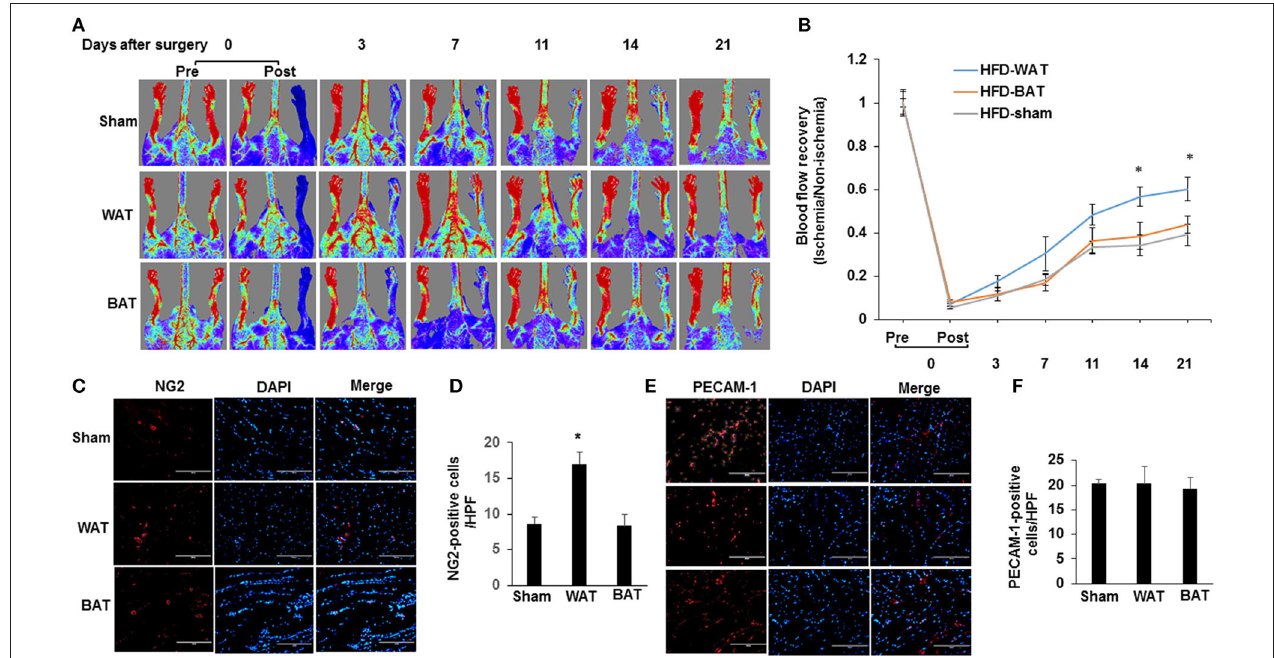
FIGURE 2 | WAT transplantation reverses HFD-impaired blood flow perfusion after femoral artery ligation. (A) Representative laser Doppler images of mouse hindlimbs at indicated time points after femoral artery ligation. Pre and post indicate immediately before and after surgery, respectively. Red color denotes normal perfusion. (B) Mean ratio of blood flow in ischemic and non-ischemic hindlimb foot pads for all animals at indicated the time points ( n = 9 per group; * P < 0.05 vs. BAT-transplanted and sham mice). (C) Representative images of arterioles as assessed by anti-NG2 immunostaining in ischemic adductor muscles 21 days after femoral artery interruption. Distance bars, 100 µ m. (D) The mean arteriole density in ischemic adductor muscles was significantly greater in WAT-transplanted mice ( n = 9 per group; * P < 0.05 vs. BAT-transplanted and sham mice). (E,F) Representative images of capillary as assessed by anti-PECAM-1 immunostaining in ischemic gastrocnemius muscles 21 days after femoral artery interruption. Distance bars, 100 µ m. Mean capillary density in ischemic gastrocnemius muscle did not differ significantly between groups ( P > 0.5). HPF indicates high-power